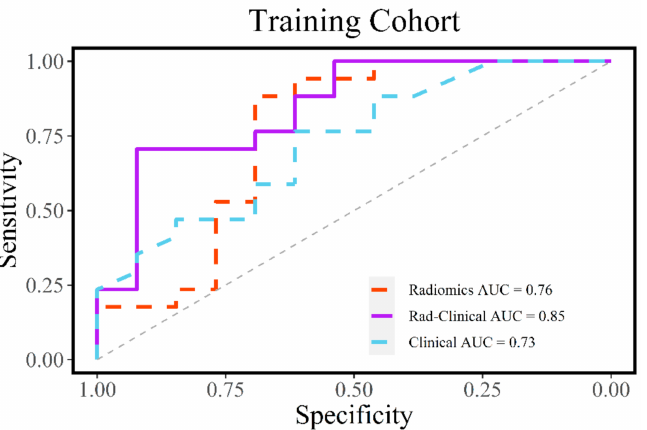
Figure 2. Receiver operating characteristic (ROC) curve analysis for the radiomic, clinical, and combined models in the training cohort. The combined model performed the best.